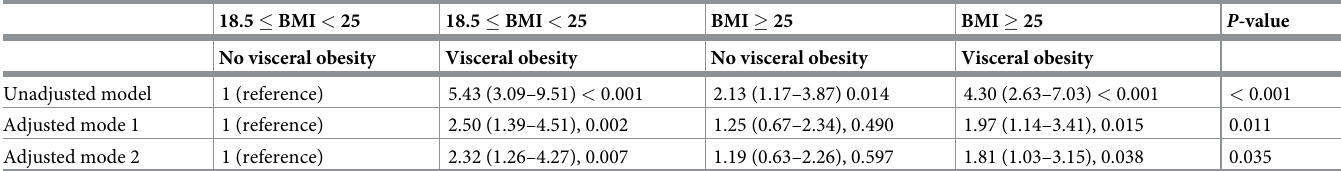
Table 4. Hazard ratio for the development of chronic kidney disease based on obesity categorization by body mass index and visceral adipose tissue area (n =